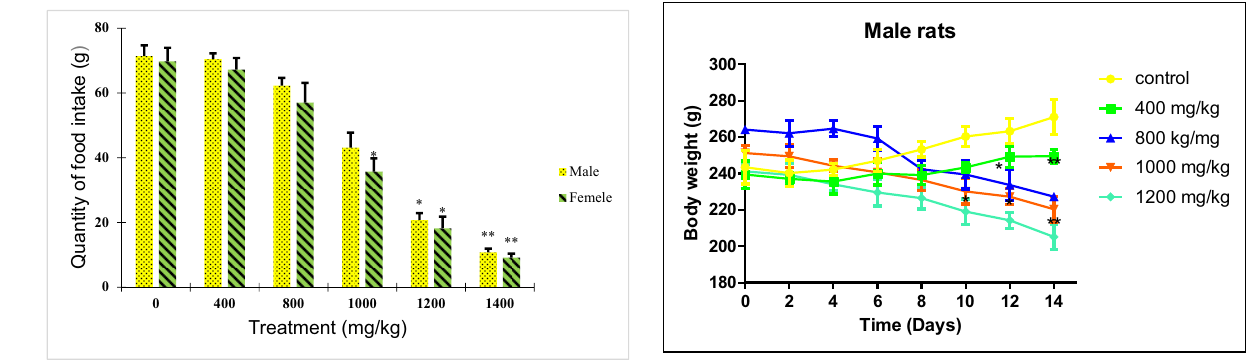
Figure 3: E ff ect of B. hispanica extracts on food intake ( g/100 g bodyweight ) of animals treated with a dose up to 14,000 mg/kg.